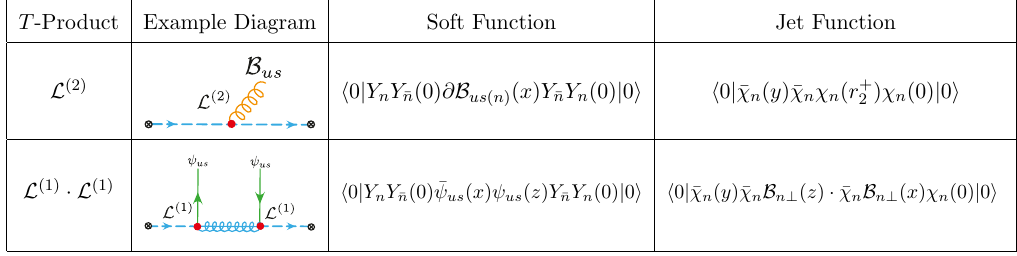
Table 4 . Leading order contributions to the The soft gluon emission arises from a single while the soft quark contribution arises from two corresponding functions when the soft gluon or quark is emitted from the (cid:22) n collinear sector. The results in this table have been obtained in